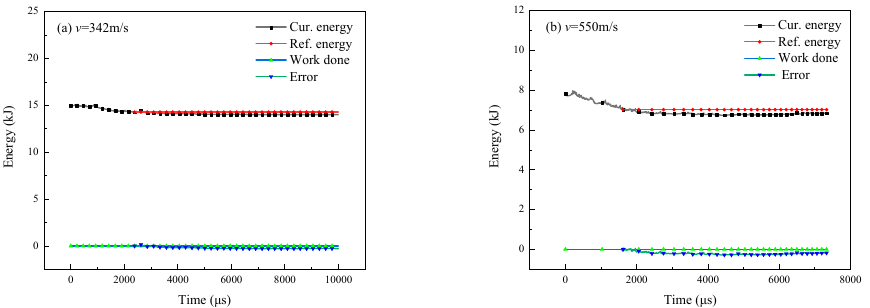
Figure 7. The energy and error versus time histories.